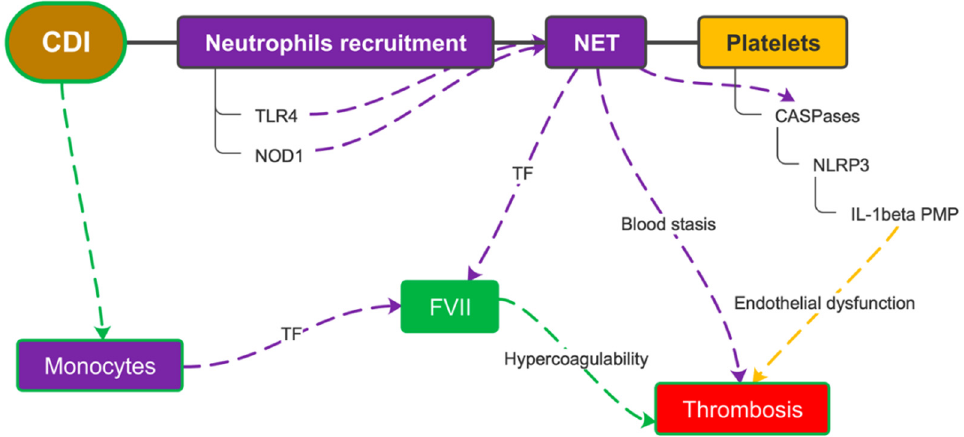
Figure 6. Leukocyte recruitment and pyroptosis due to CDI causes the release of tissue factor from monocytes and neutrophils. This acts in synergy with platelet activation and, together with the endothelial dysfunction caused by the inflammatory microenvironment, favors thrombus formation. CDI = C. difficile infection; TLR4 = toll-like receptor 4; NET = neutrophil extracellular trap; TF = tissue factor; NLRP3 = nucleotide-binding oligomerization domain and leucine-rich repeat-containing receptors protein 3; IL-1beta = interleukin-1 beta; PMP = platelet microparticles; FVII = coagulation factor VII.